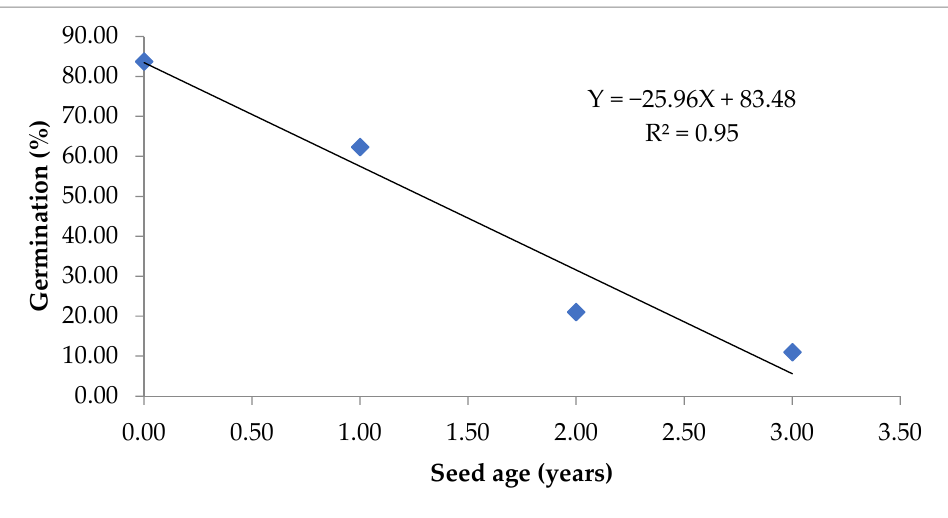
Figure 3. Simple linear regression between seed age and germination.